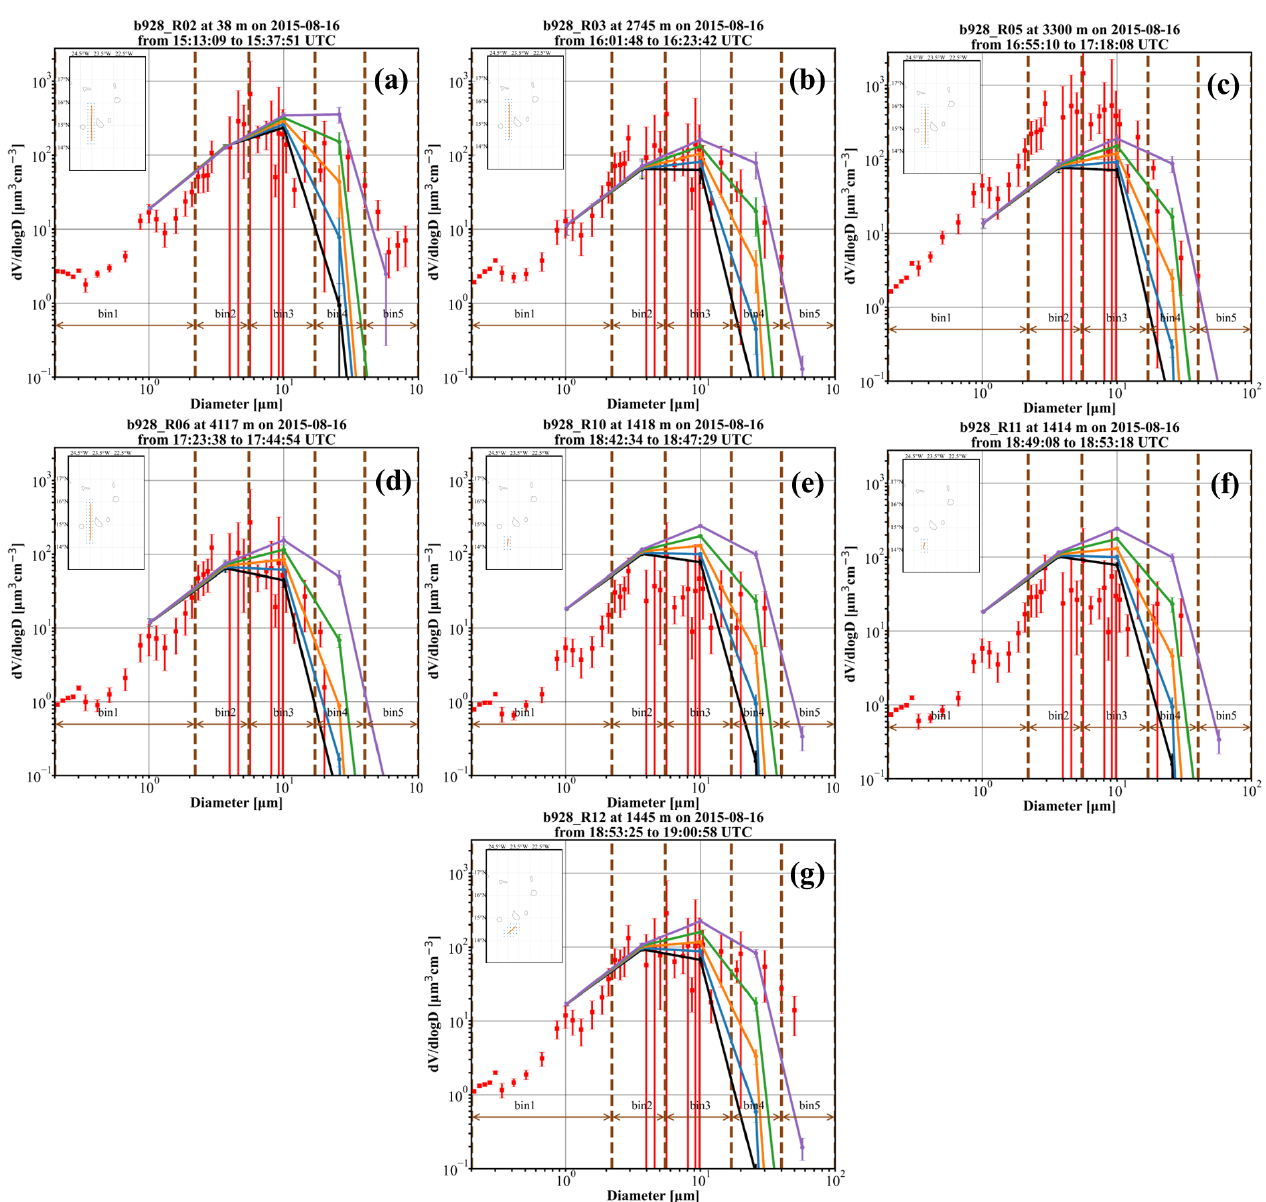
Figure 7. Modeled and observed dust PSD of flight b928 for straight-level runs (a) R02, (b) R03, (c) R05, (d) R06, (e) R10, (f) R11, and (g) R12. The in situ observations are shown with red squares (along with the total instrumentation error). The collocated modeled PSDs are shown with lines for the CONTROL run (black), UR20 (blue), UR40 (orange), UR60 (green), and UR80 (purple) and the corresponding standard deviation with the associated error bars. The brown vertical lines indicate the limits of the model size bins. The inlet maps show the flight segment track and the collocated model grid